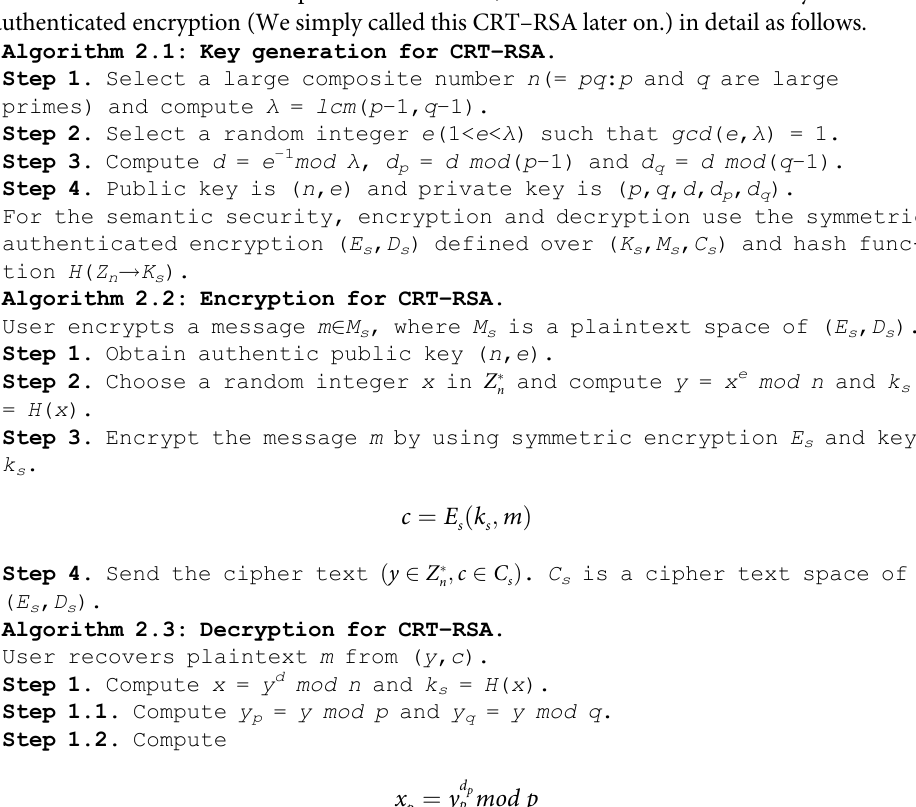
Algorithm 2.3: Decryption for CRT–RSA